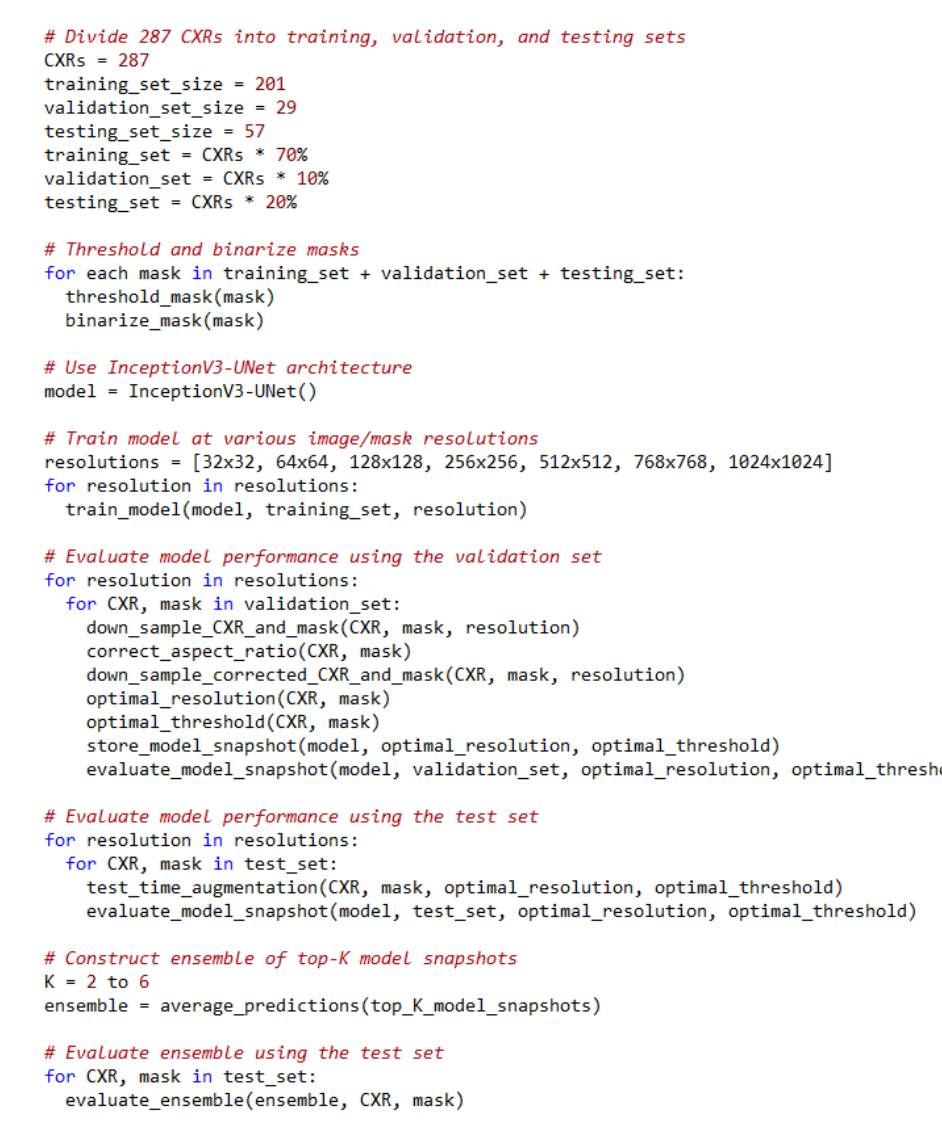
Figure 4. Pseudocode of our proposal.